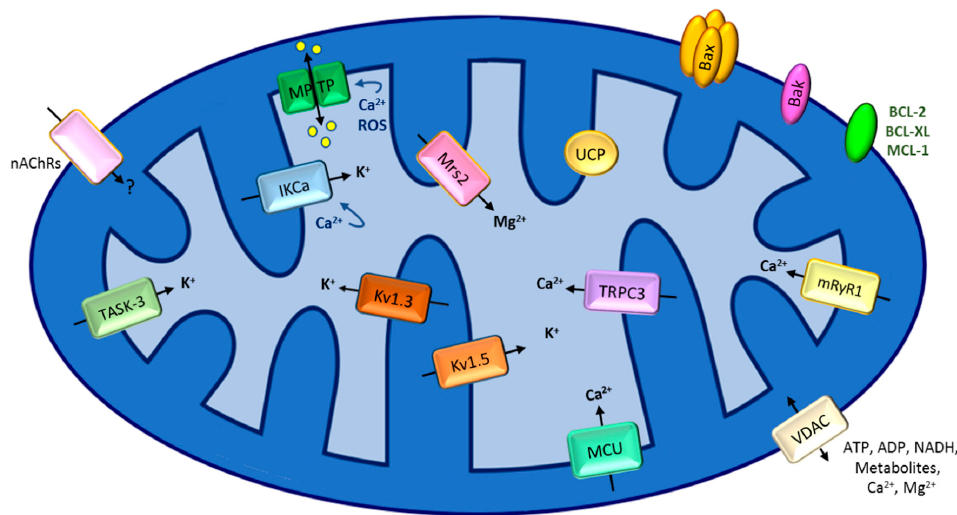
Figure 2. Mitochondrial ion channels and pores involved in apoptosis and chemo-resistance. The figure summarizes the channels/pores treated in this review, i.e., those linked to chemo-resistance. See text for details. The negative membrane potential across IMM (approximately − 180